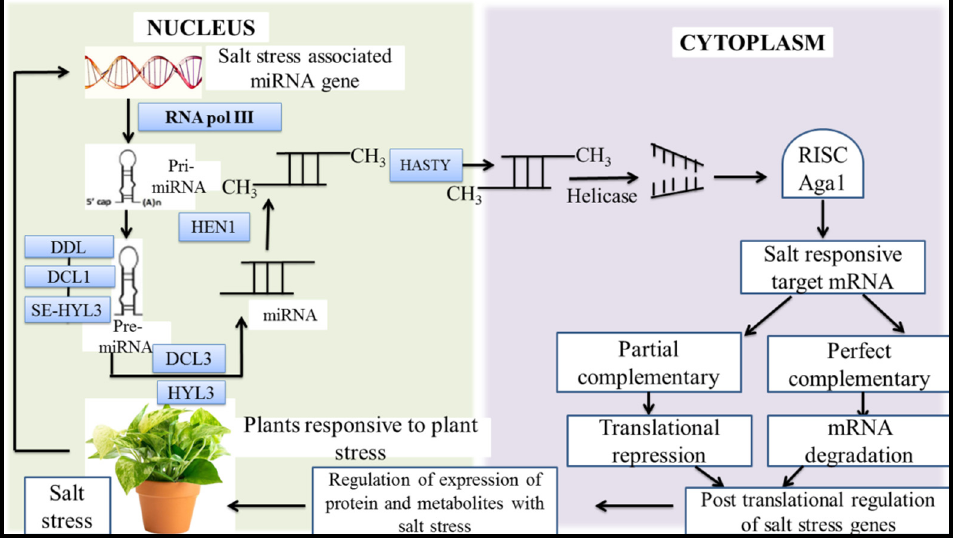
Figure 4. Pathway showing post-transcriptional regulation of salt stress-responsive plant genes mediated by miRNA.